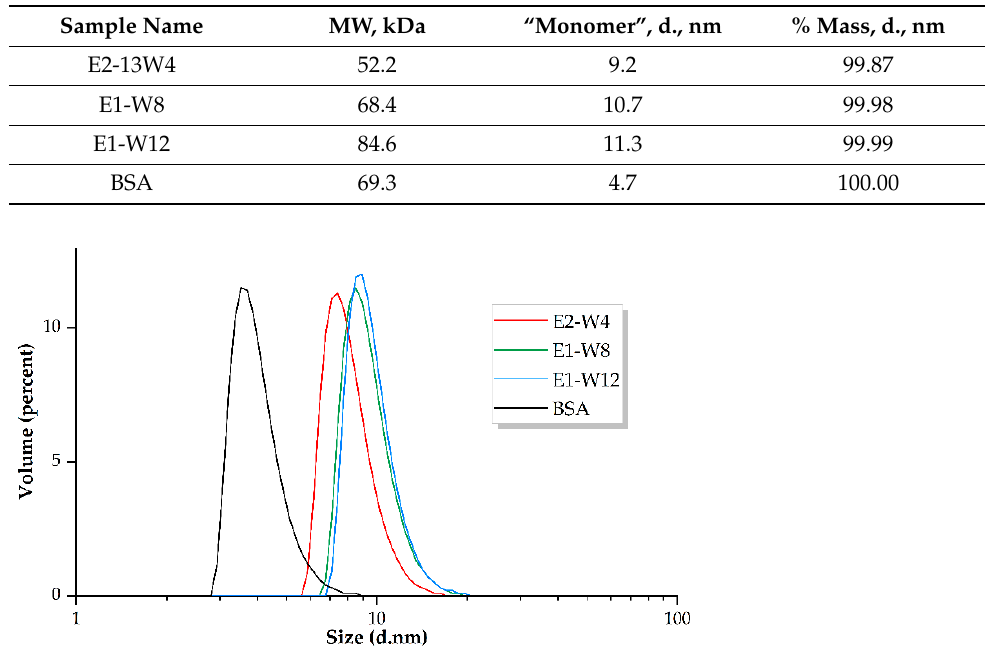
Table 5. Measurement results from the Malvern software.